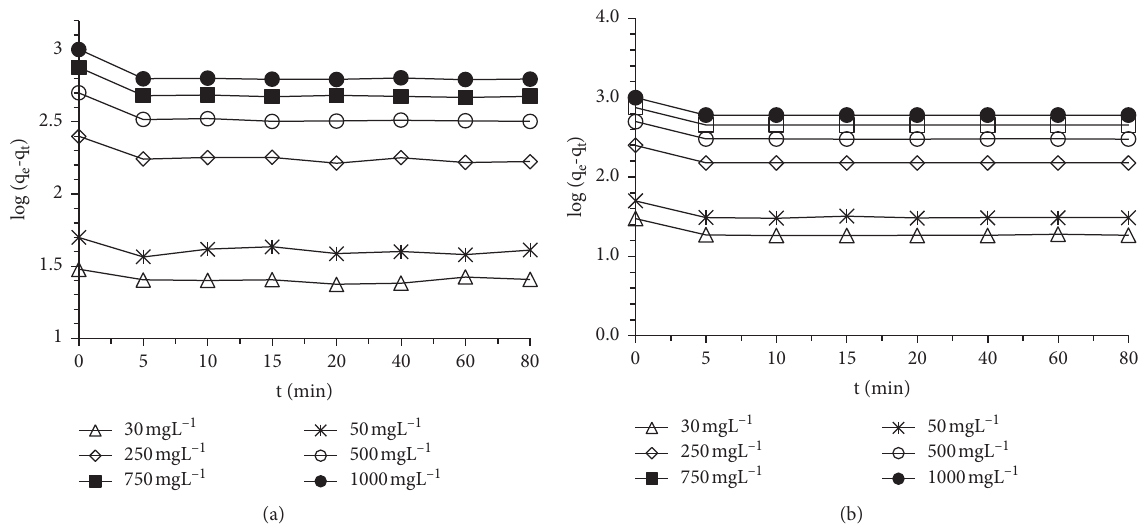
Figure 12: Pseudo-first-order adsorption kinetics of MR onto ANb (a) and ANp (b).